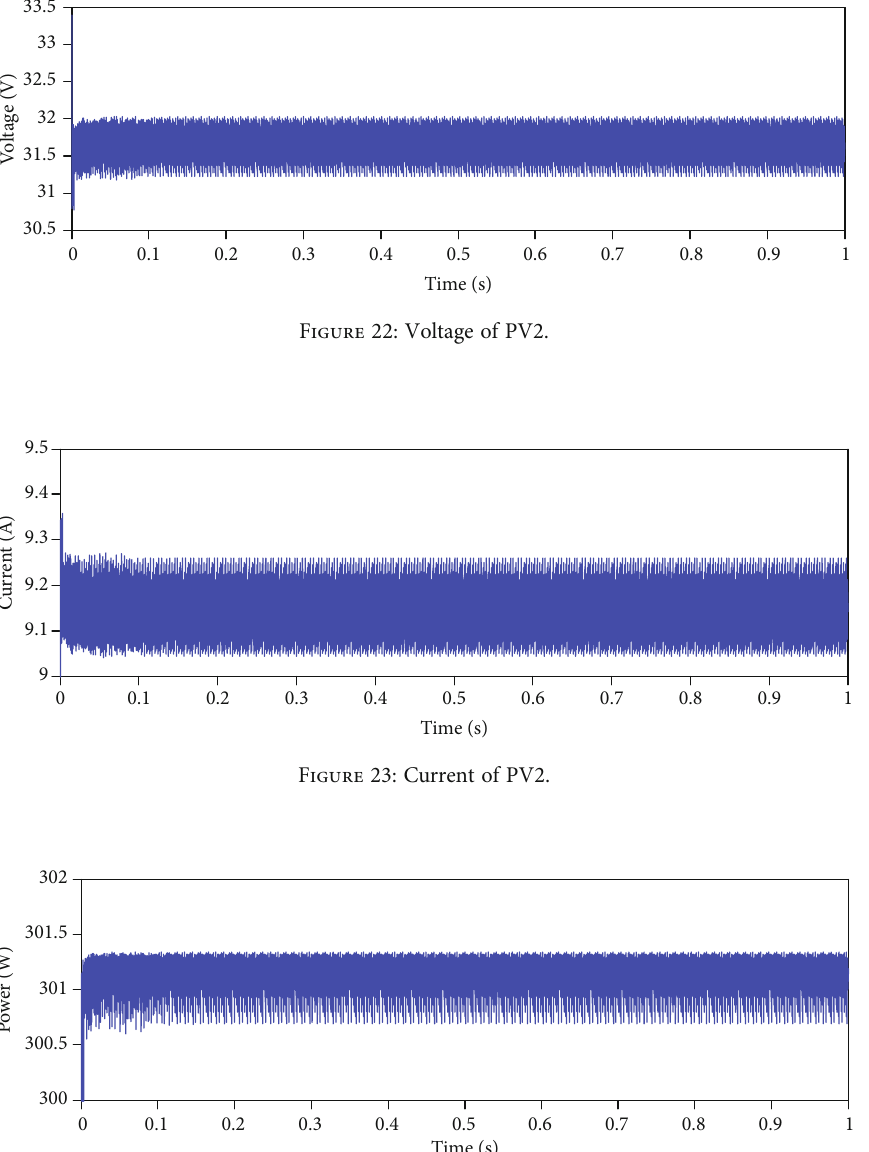
Figure 24: Output power of